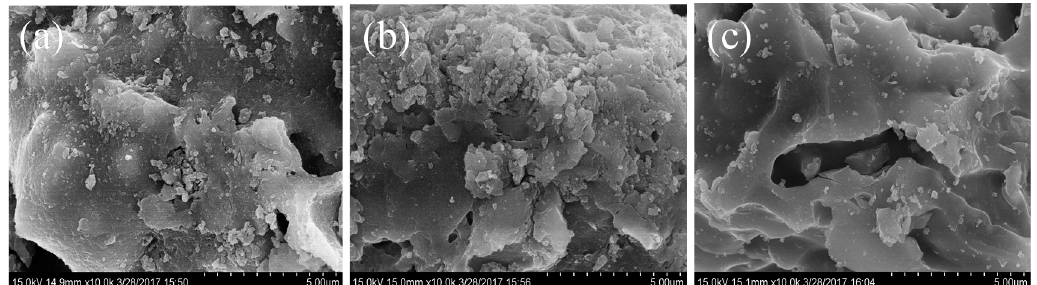
Figure 3. The SEM images of PRBP ( a ), GCBP ( b ), and HCBP ( c ).